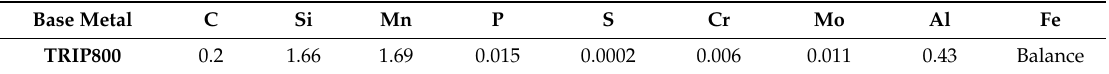
Table 1. The chemical composition of the TRIP800 steel (% weight).